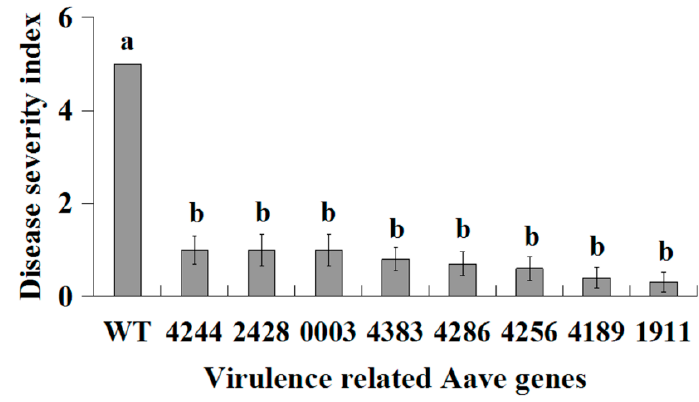
Figure 2. Pathogenicity of the eight mutants to watermelon leaves. Disease severity index was determined as described in Figure 1 and presented as means + standard errors ( n = 6). Columns with different letters (a, b) are significantly different according to LSD test ( p = 0.05).